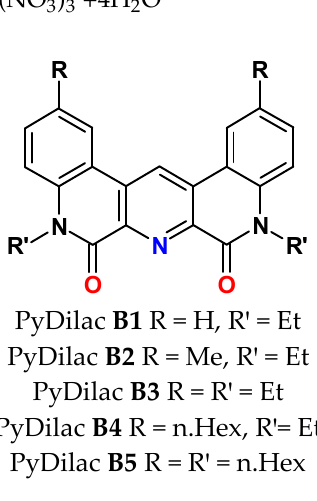
Figure 8. The structures of studied dilactams.